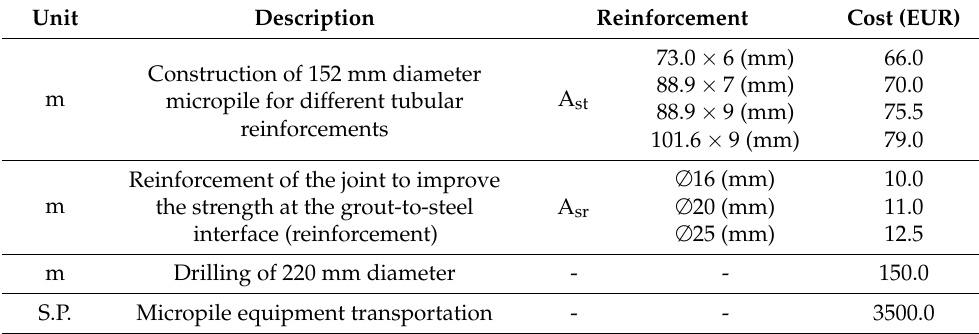
Table 3. Cost of construction units considering prices of 2022.